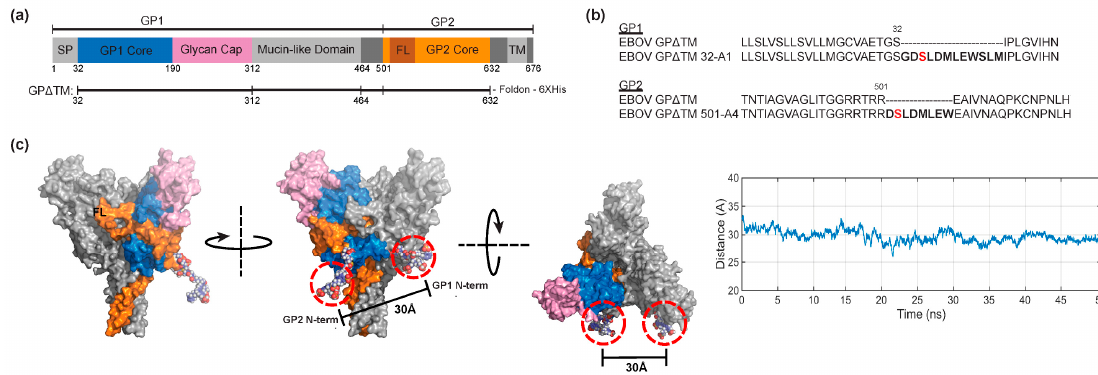
Figure 1. Site-specific fluorescent labelling of EBOV GP for smFRET. ( a ) Structural organization of GP ∆ TM. Adapted from Ref. [11]. FL, fusion loop; SP, signal peptide; TM, transmembrane helix. ( b ) EBOV GP ∆ TM and GP ∆ muc were modified to contain peptide tags (bold) in GP1, between amino acid position 32 and 33, and in GP2, between amino acid positions 501 and 502, to facilitate enzymatic labelling with fluorophores at the serine residues highlighted in red. ( c ) Surface rendering of EBOV GP ∆ TM (derived from PDB accession 5JQ3 [11]) with fluorophores attached. MD simulation of fluorescently labeled GP ∆ TM 32-A1 / 501-A4 predicts an inter-fluorophore distance of approximately 30 Å. After minimization and equilibration, the time-averaged distance between the centers of mass of the fluorophores was determined through a 50-ns simulation (see Section